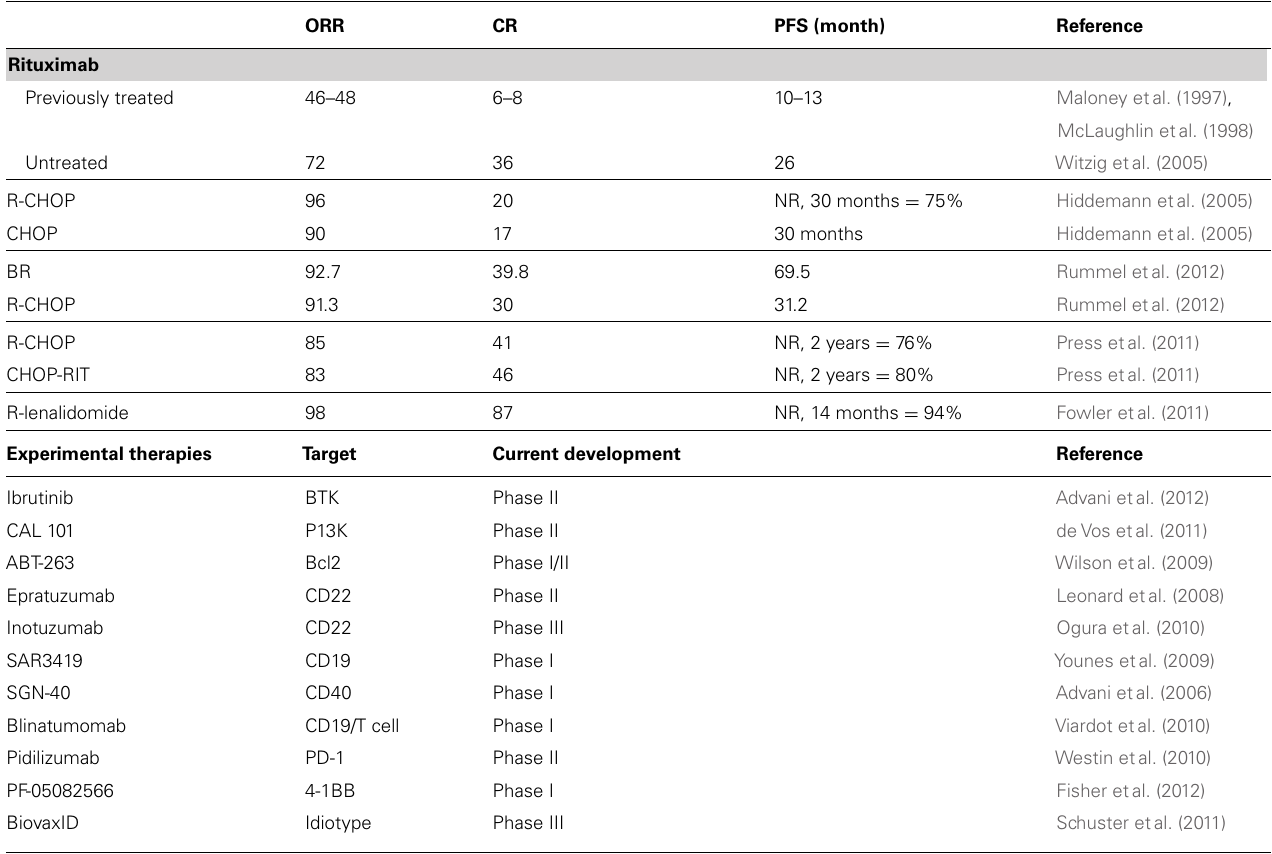
markers. In 1994, the phase I trial of a monoclonal antibody tar-